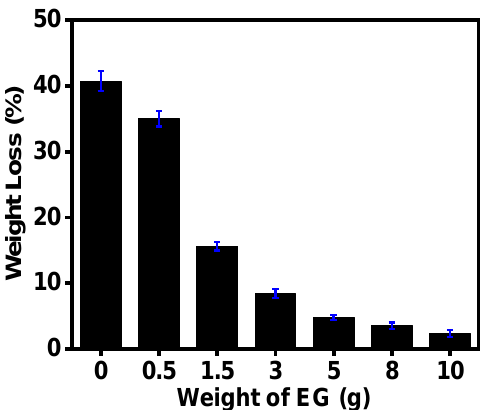
Figure 11. Weight loss for the PU foams with an increasing amount of EG after burning.